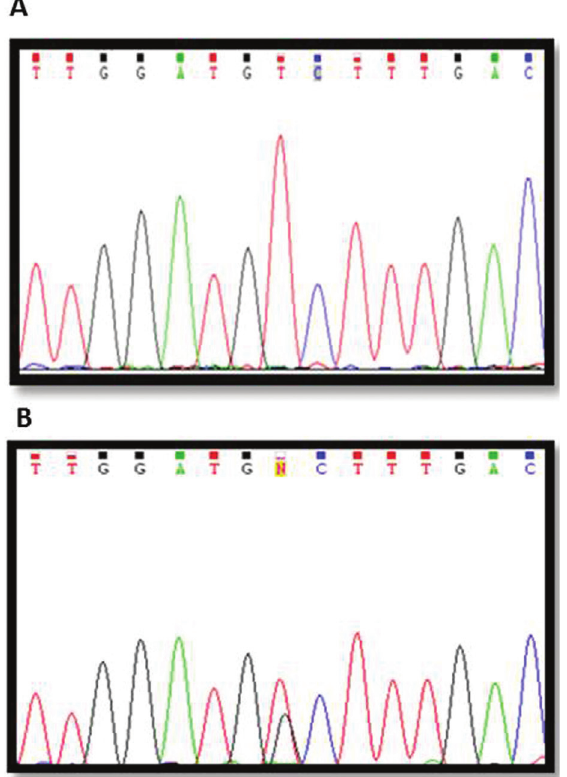
Figure 3 - Mutational analysis of the arylsulfatase A ( ARSA ) gene in the Iranian family with metachromatic leukodystrophy. Direct sequencing of the ARSA gene shows a homozygous G to T transition (c.1070; Gly357Val) in patients (no. 1, 2, 3 in pediatric) (A), and a heterozygous G to T transition in their parents